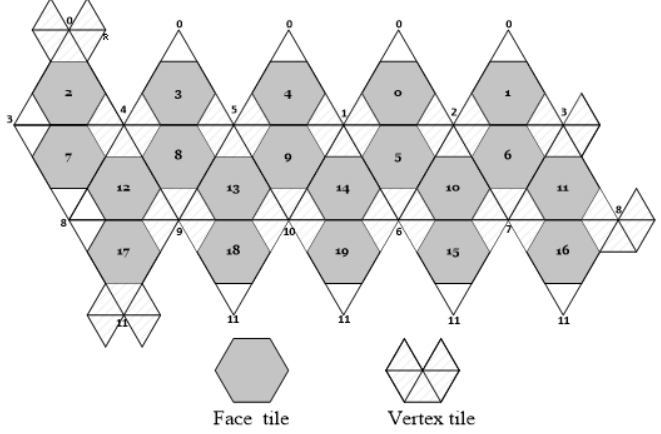
Figure 10. Two types of tiles on the unfolded faces of the icosahedron including 20 face tiles (gray) and 12 vertex tiles (white). The indices of each face and vertex are marked (source—own study).